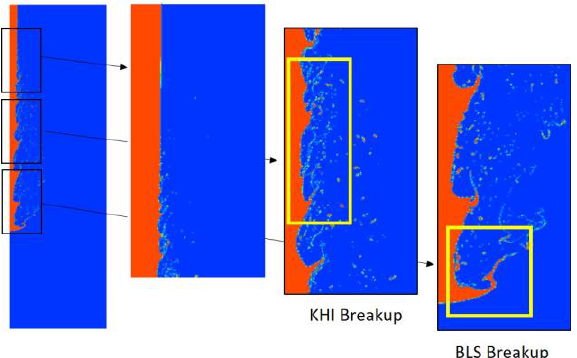
Figure 4. Illustration of jet breakup by KHI and BLS.